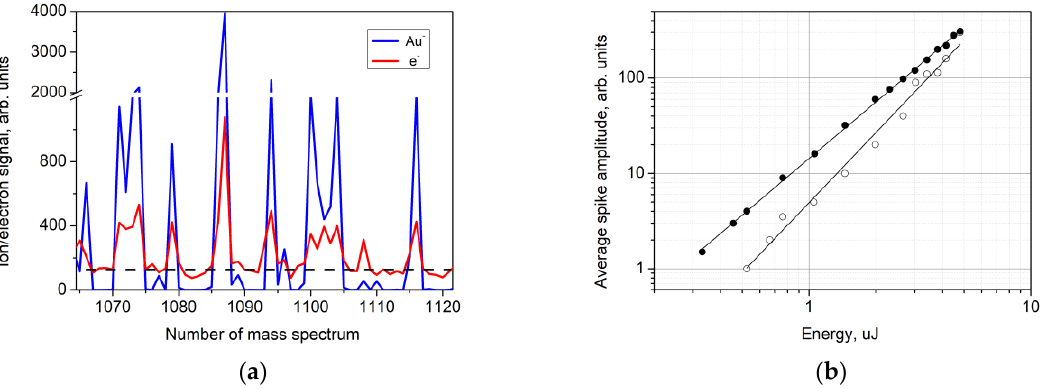
Figure 5. ( a ) A record of the Au − ion signal (blue) and e - electron signal (red) for successive single mass spectra. ( b ) Average amplitude of the electron signal spikes vs. the laser pulse energy in scanning mode (filled circles) and in static mode (open circles).